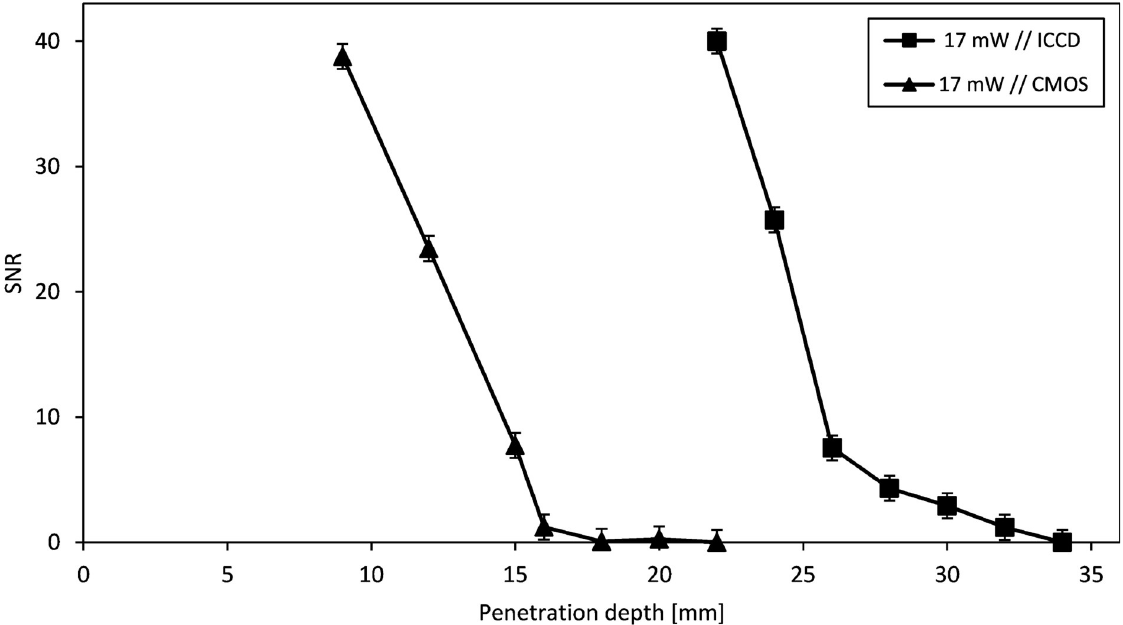
Fig 2. Depiction of obtained signal-to-noise ratios (SNR) imaging tumor phantoms at different depths under the tissue surface.